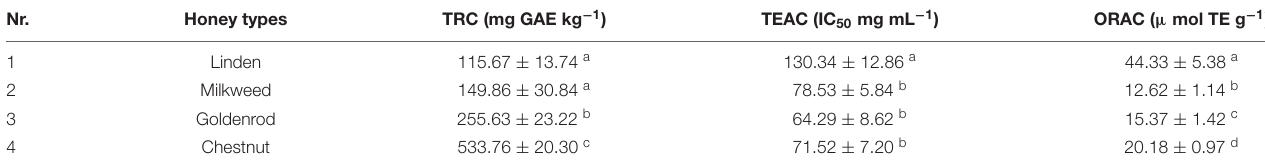
TABLE 3 | Total antioxidant capacities of the honey samples.